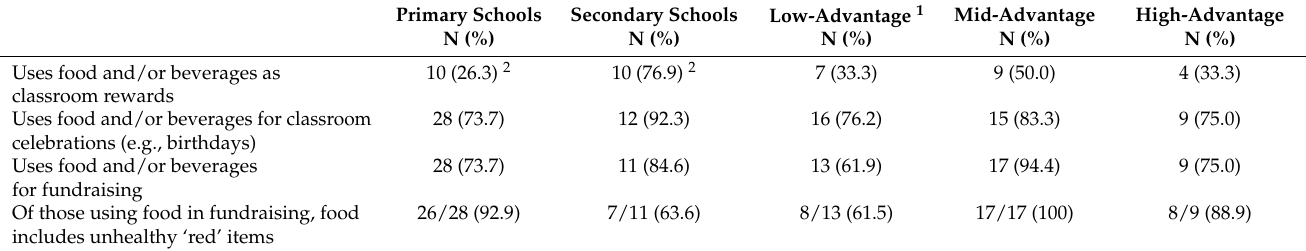
Table 2. Hawke’s Bay schools using food and/or beverages in class and school activities.